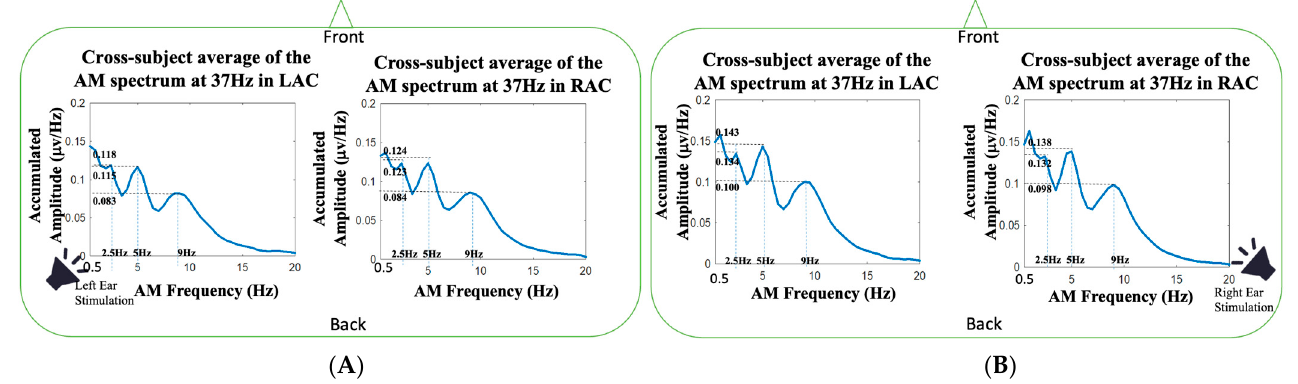
( B ) Figure 4. The FM spectra averaged across the twenty-five subjects in our study: ( A ) The cross-subject average of FM spectrum in LAC and RAC during left-ear auditory stimulations; ( B ) the cross-subject average of FM spectrum in LAC and RAC during right-ear auditory stimulations. The noteworthy benefit of HHSA is its capability to analyze AM spectrum for a meas- ured signal. Figures 5 and 6 demonstrate the AM spectra of the auditory responses at 37 and 74 Hz, respectively. The cross-subject averages of AM spectra at 37 Hz during left and right monaural stimulations are shown in Figure 5A,B, respectively. Both the left and right monaural stimulations presented three clear spectral peaks at 2.5, 5 and 9 Hz. The ampli- tudes of 2.5, 5 and 9 Hz of LAC in left-ear stimulations were 0.115, 0.118 and 0.083 μ v/Hz, respectively, and the amplitudes of 2.5, 5 and 9 Hz of LAC in right-ear stimulations were 0.123, 0.124 and 0.084 μ v/Hz, respectively. For the AM spectra of 37 Hz in right-ear stim- ulations, the amplitudes of 2.5, 5 and 9 Hz in LAC were 0.134, 0.143 and 0.100 μ v/Hz, respectively, and the amplitudes of 2.5, 5 and 9 Hz in RAC were 0.132, 0.138 μ v/Hz and 0.098 μ v/Hz, respectively. The 2.5, 5 and 9 Hz were the three main peaks at the 37 Hz FM